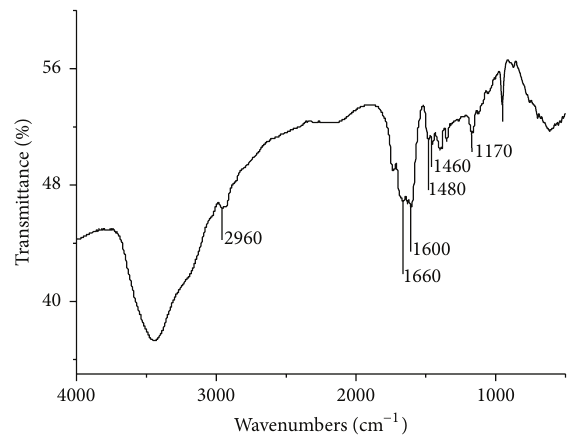
Figure 3: FTIR of branched cationic